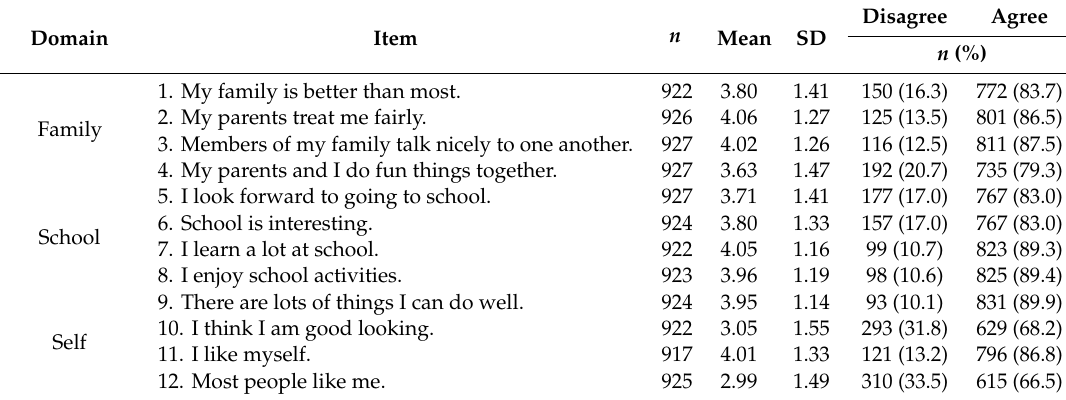
Table 2. Adolescents’ responses on MSLSS life satisfaction